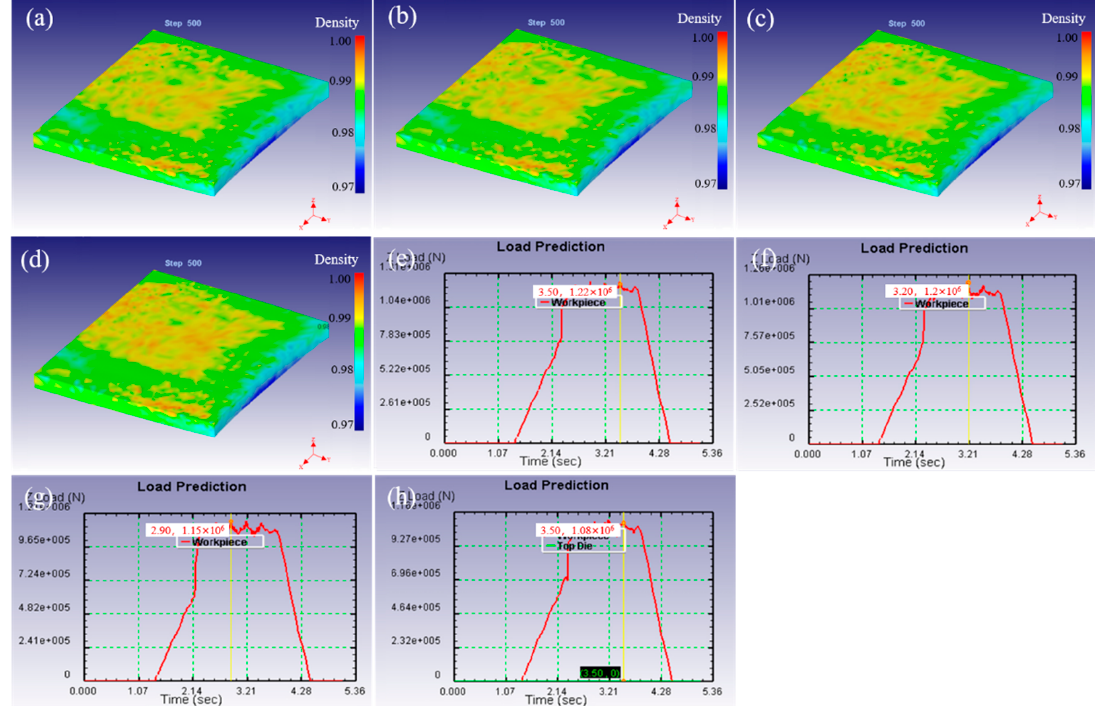
Figure 4. The distribution of density field ( a – d ), and roll force ( e – h ) by FEM simulation under different rolling temperatures of 1300–1600 °C.